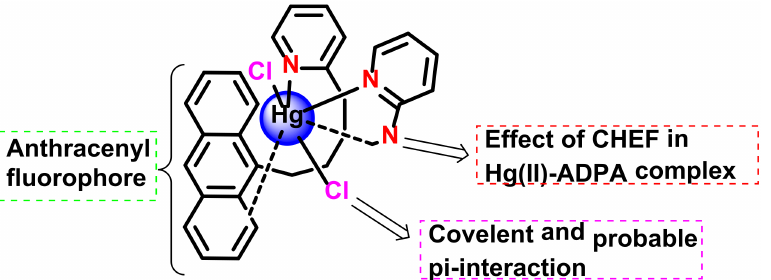
Figure 11. Formation of stable Hg 2+ /ADPA complex, which helps in restoring its fluorescence. Reproduced with permission from [29] by American Chemical Society.